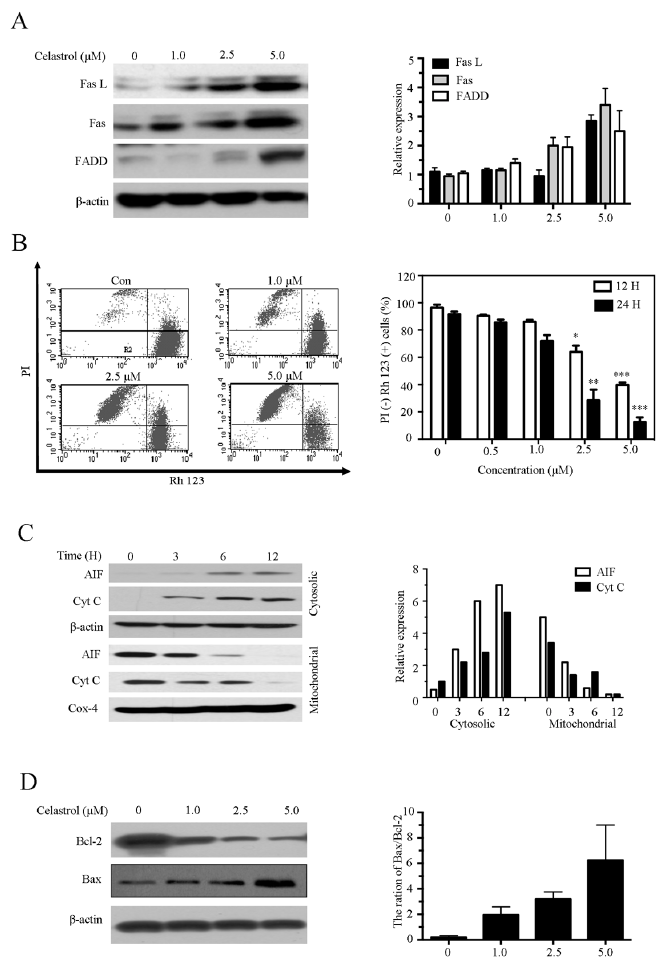
Figure 4. Celastrol induces apoptosis via the extrinsic and intrinsic pathway in Kasumi-1 cells. ( A ) Kasumi-1 cells were treated with various concentrations of celastrol for 24 h, and the levels of Fas, FasL and FADD were determined using western blot; ( B ) Celastrol downregulated the MMP. Kasumi-1 cells were treated with the indicated concentration of celastrol for 12 or 24 h, and the MMP was evaluated using rhodamine-123 PI staining and flow cytometry; ( C ) Celastrol induced release of AIF and Cyt C. Kasumi-1 cells were treated with 2.5 μ M celastrol for 3, 6 or 12 h. Then, the cytosolic and mitochondrial fractions were separated and evaluated using western blot; ( D ) Celastrol modulated the expression of Bcl-2 family proteins in Kasumi-1 cells. Cells were treated with various doses of celastrol for 24 h, the expression of Bcl-2 and Bax were assayed using western blot. The ratio of Bax/Bcl-2 expression was analyzed. Data are from three independent experiments. * p < 0.05, ** p < 0.01, and *** p < 0.001.